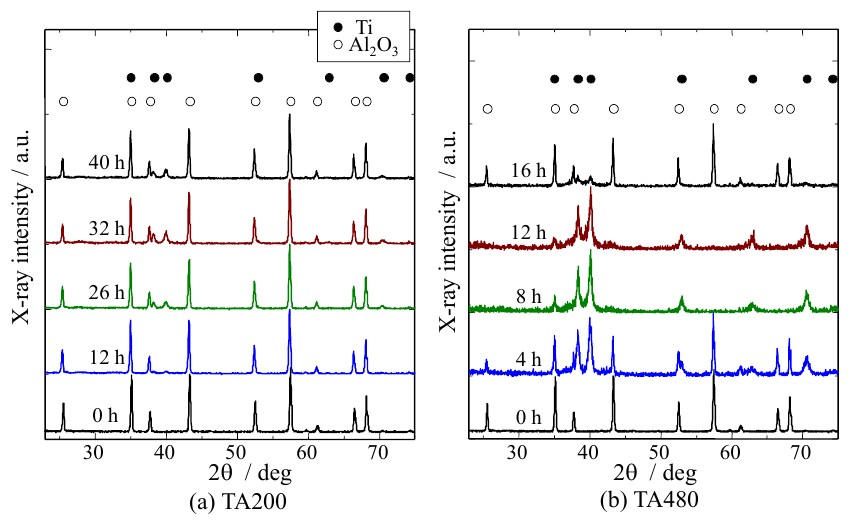
Figure 15. Appearance of the samples.